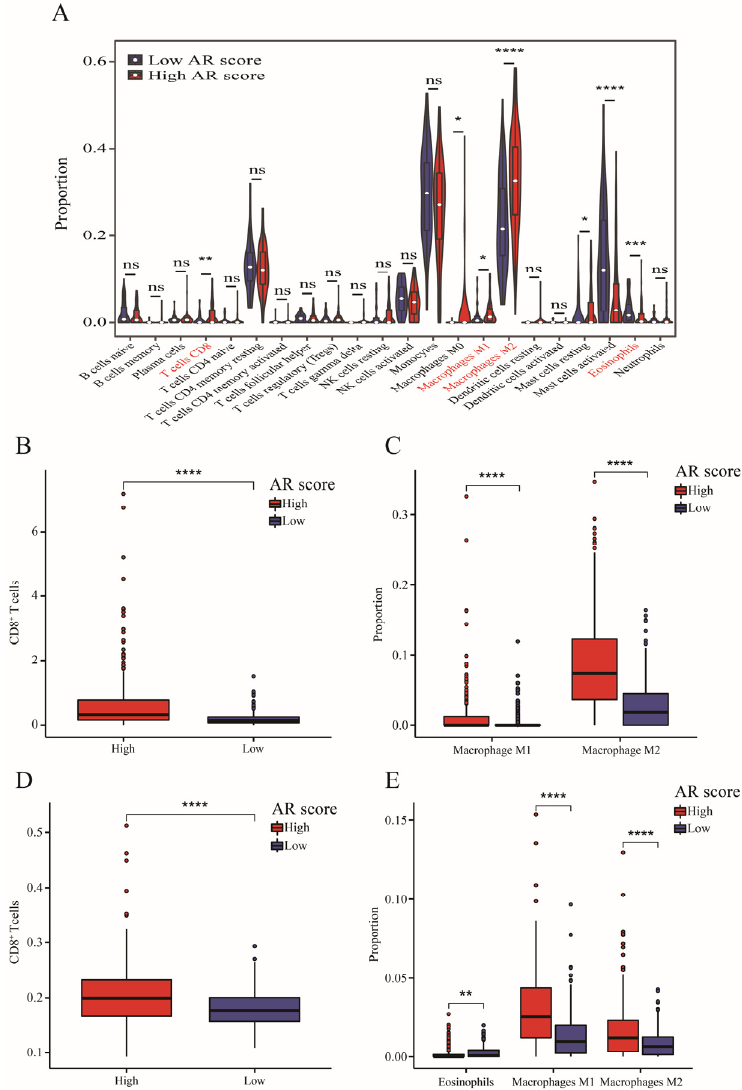
Figure 5. The immune infiltrating analysis. ( A ) The infiltrating level of 22 immune cells between high- and low-AR groups via “CIBERSORT” algorithm. ( B – E ) Validation of immune infiltrating results through “MCP-counter”, “quanTIseq”, “TIMER” and “xCell” algorithms. Data in ( A – E ) were analyzed by Wilcoxon test; ns, no significance; * p < 0.05, ** p < 0.01, *** p < 0.001 and **** p < 0.0001 .